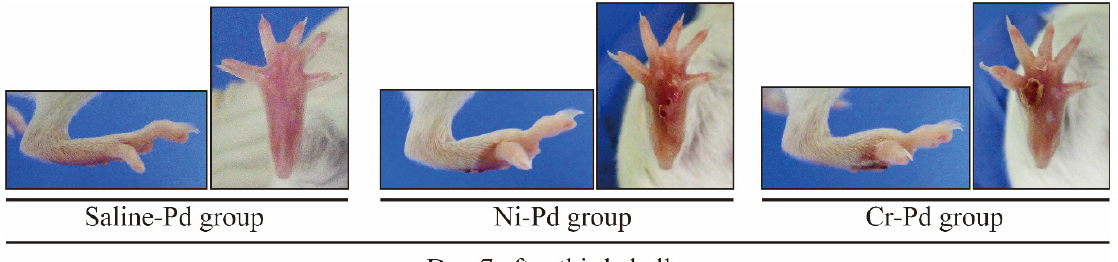
Figure 1. Footpad swelling in the mouse model of cross-reactive metal allergy. Footpad swelling was measured at various time points. The Cr-Pd, Ni-Pd, and Saline-Pd groups were analyzed at 1, 3, and 7 days after the third challenge. Bars and error bars indicate the mean ± SD. Statistical significance was tested by the Dunn’s test (* p < 0.05, ** p < 0.01).